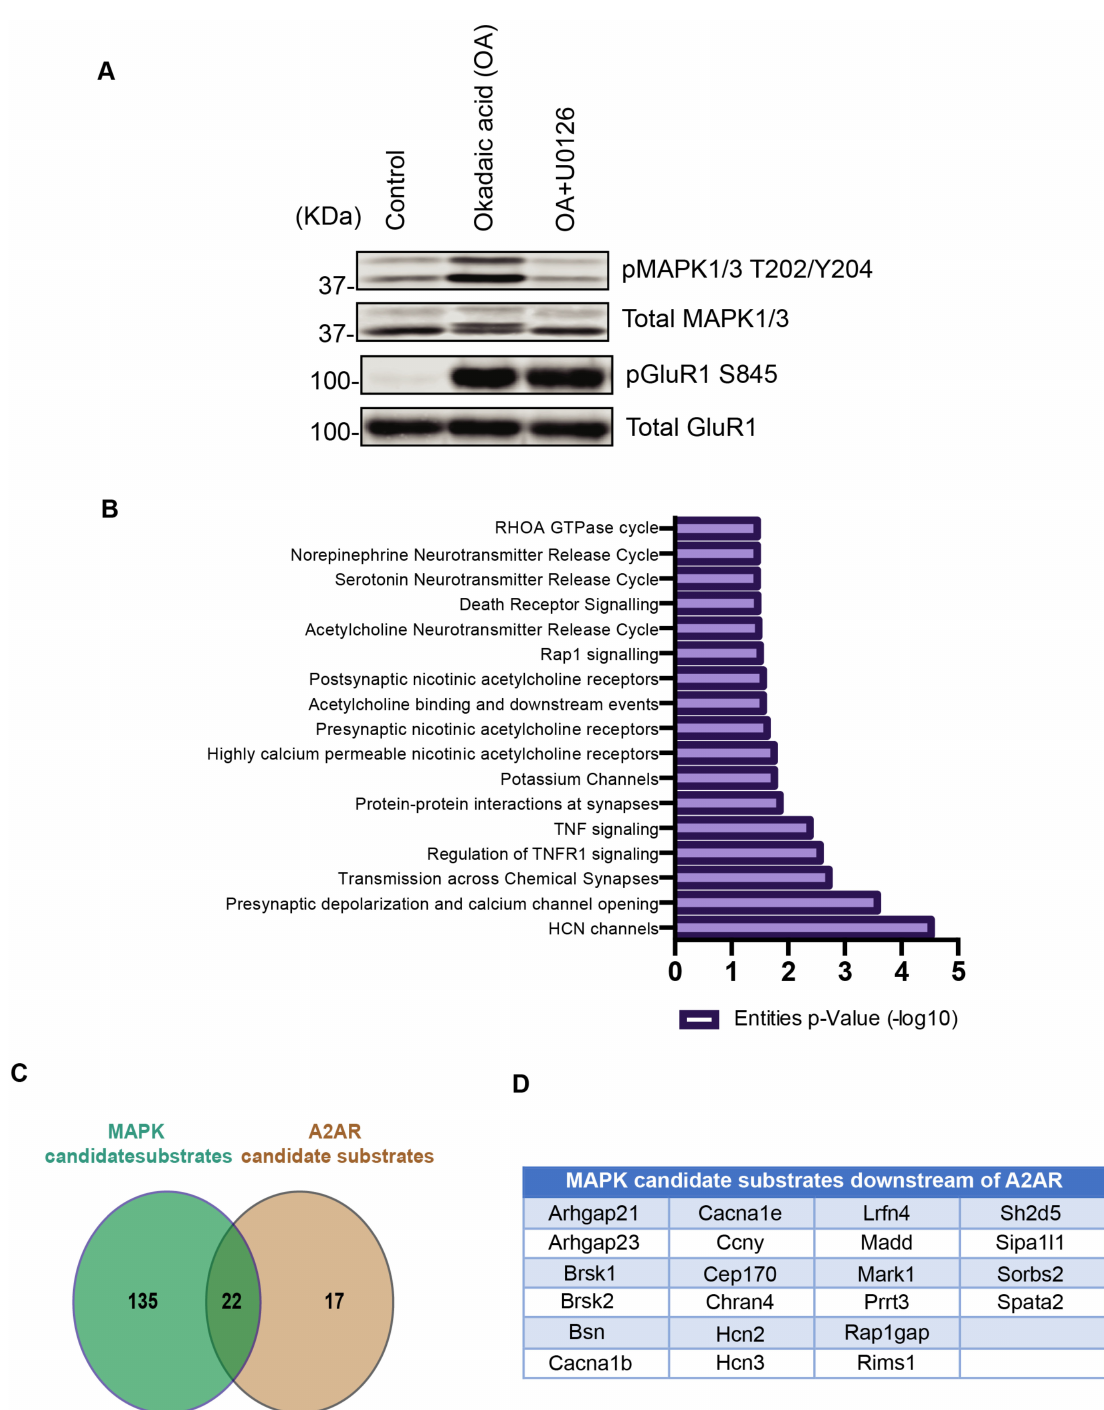
Figure 5. Identification of MAPK candidate substrates downstream of A2AR signaling in stria- tum/NAc. ( A ) Screening of phosphoproteins downstream of MAPK-mediated signaling. Stri- atal/accumbal slices were treated with okadaic acid (1 µ M) for 60 min after pretreatment of MEK inhibitor U0126 (10 µ M) for 30 min. OA induced the phosphorylation ERK at T202/Y204 and PKA substrate GluR1 at S845, whereas the pretreatment of MEK inhibitor reduced the phospho- rylation of ERK but had no effect on PKA substrate GluR1 phosphorylation; ( B ) In silico anal- ysis of the identified MAPK candidate substrates using the Reactome database (available online: http://www.reactome.org/ (accessed on 7 November 2021)) is shown; ( C ) Overlapping of MAPK and A2AR candidate substrates; ( D ) List of MAPK candidate substrates downstream of A2AR